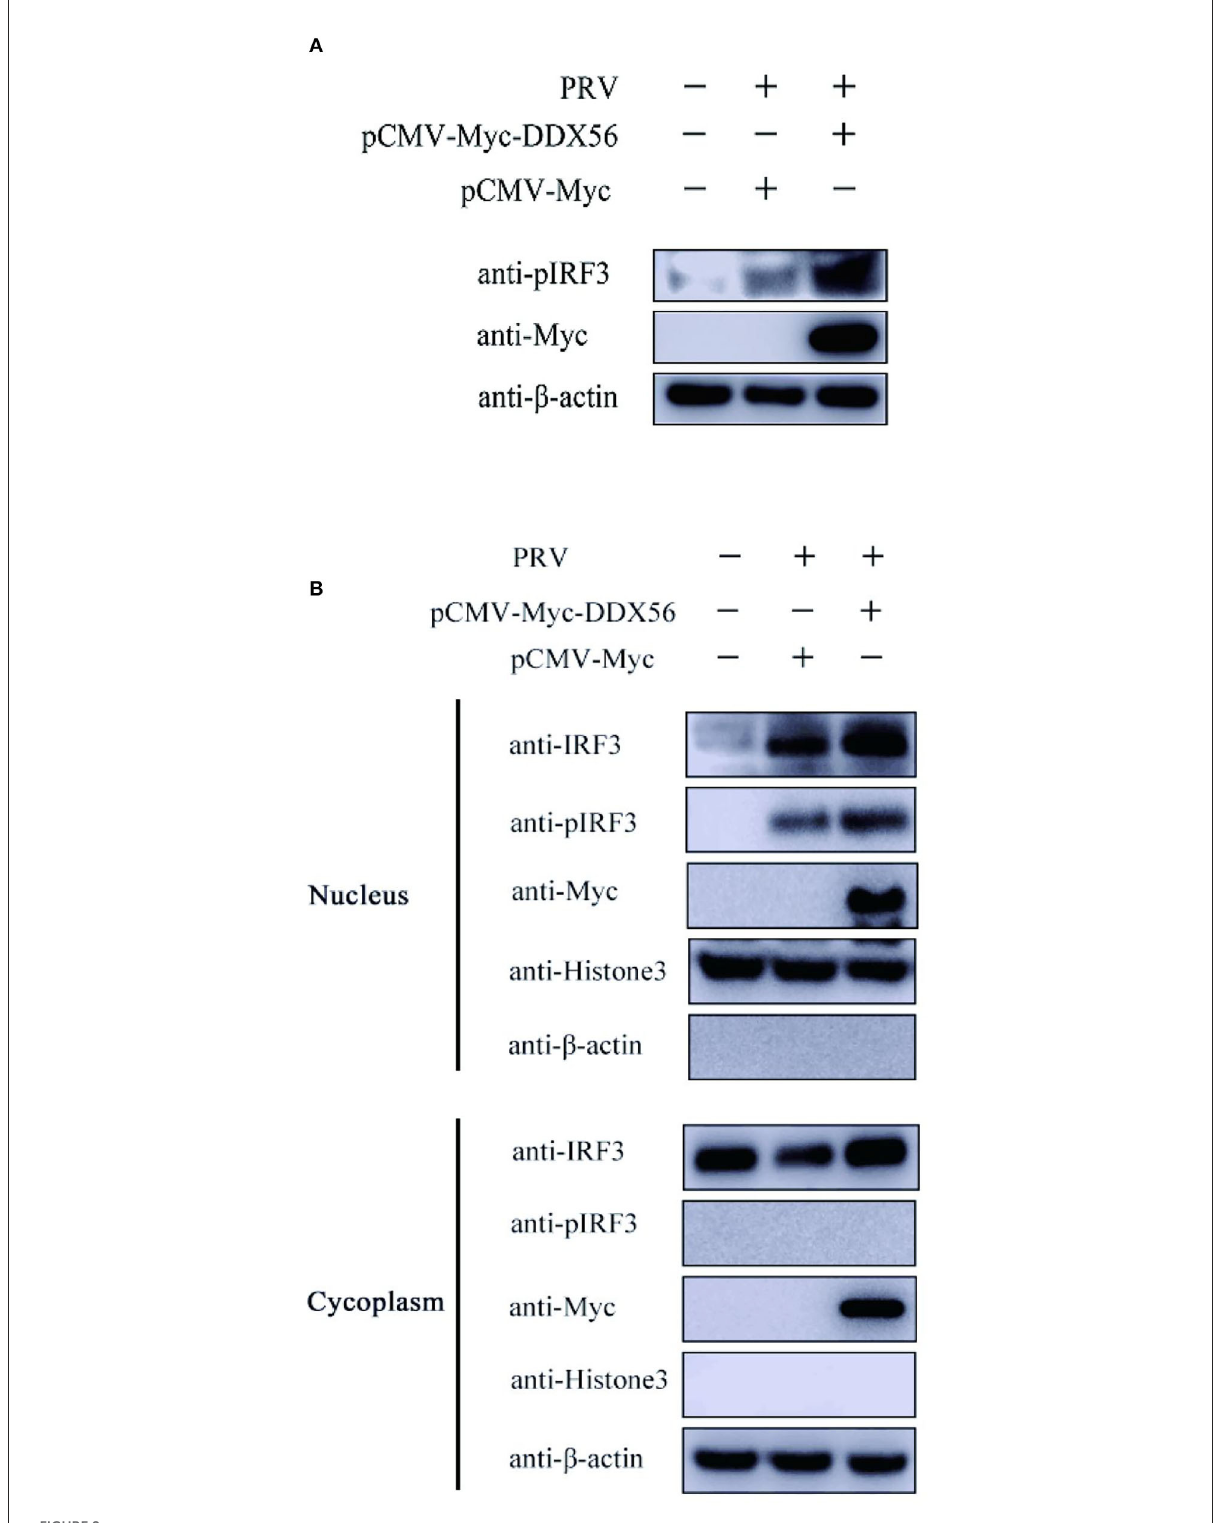
FIGURE8 DDX56 promotes IRF3 phosphorylation and nuclear translocation induced by PRV. (A) PK15 cells were transfected with empty vector (EV, 1 µ g) or pCMV-Myc-DDX56 (1 µ g) plasmid for 24h, then cells were infected with 100 TCID 50 PRV for 12h. Cells were collected for